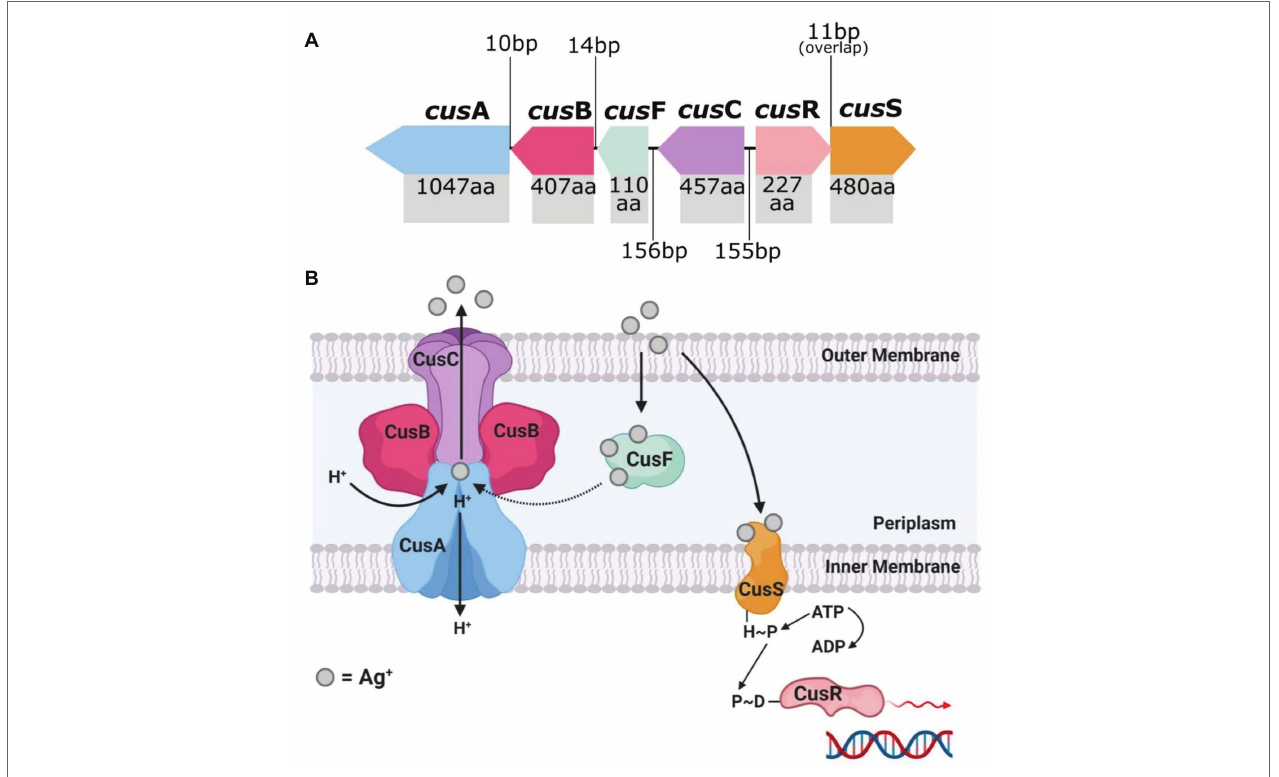
FIGURE 2 | The top image (A) shows the genetic arrangement of the cus operon and includes the intergenic DNA base pair (bp) gaps/overlaps and each cus gene’s protein product amino acid (aa) length. The bottom image (B) is a graphical representation of the protein arrangement and functions of the encoded membrane bound Cus efflux system. Created in Inkscape (A) and BioRender (B) . Adapted from Randall et al.